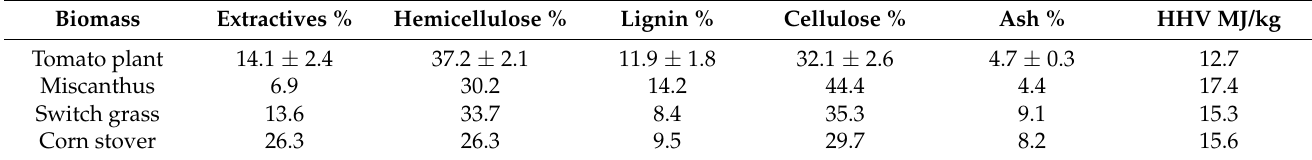
Table 1. Comparison of tomato plant biomass with other